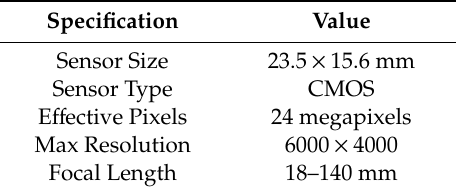
Table 4. The specifications of Nikon digital single-lens reflex (DSLR) camera.